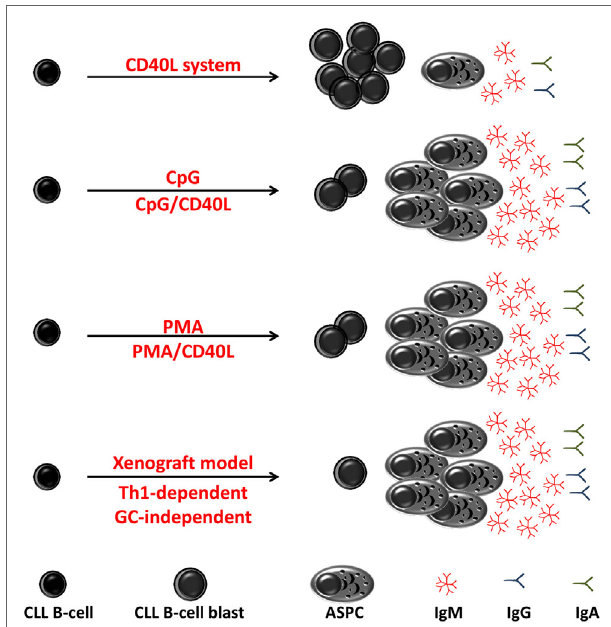
FigURe 3 | Differentiation of chronic lymphocytic leukemia (CLL) B-cell in vitro and in vivo . In vitro and in vivo (xenograft model) CLL B-cells differentiate into antibody-secreting plasma cells (ASPCs) with different efficiency. In response to stimulation through CD40 ligation (CD40L), CLL B-cells poorly differentiated into antibody-secreting plasma cell (ASPC) and showed an activated phenotype and morphology and low levels of Ig secretion. In response to CpG or to phorbol myristate acetate (PMA), CLL B-cells show a high propensity for differentiation into ASPC that predominantly secrete IgM. In xenograft model, differentiation of CLL B-cells has been shown to be induced by T helper 1-polarized T-bet + T-cells and not classical T follicular helper cells, i.e., in the absence of germinal